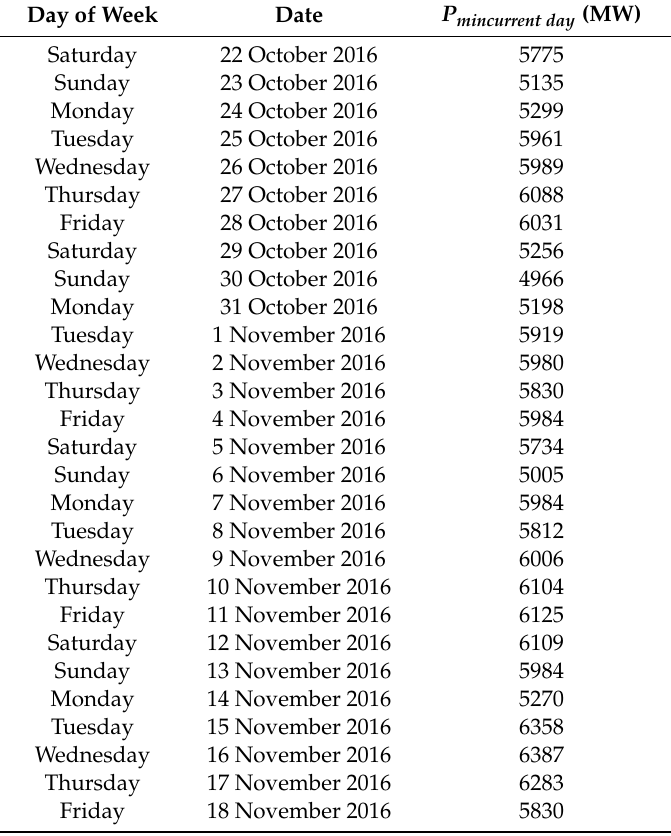
Table 7. The target data for valley load training.